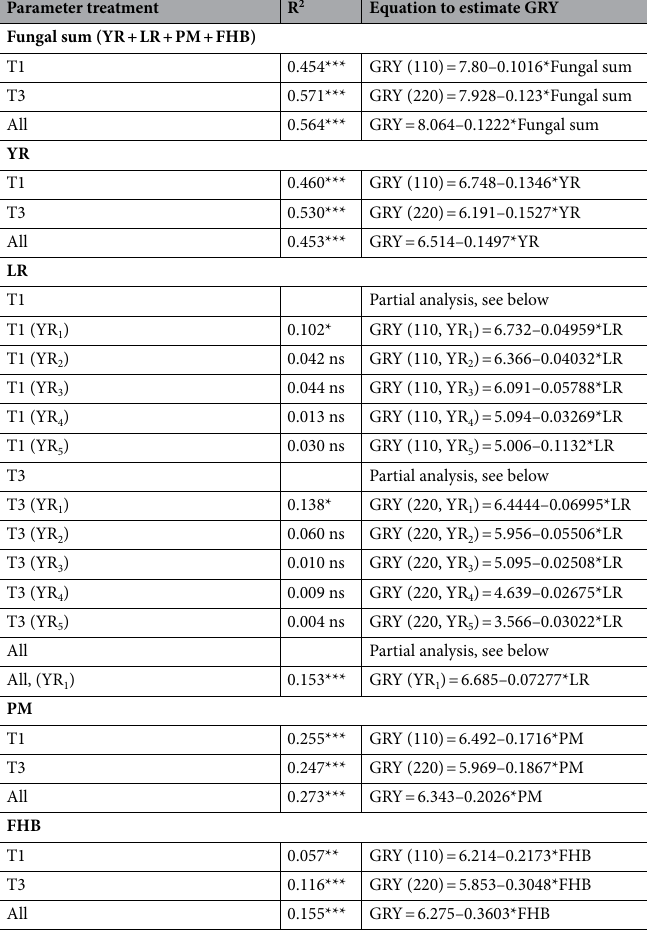
Table 4. Bivariate analysis between diseases (YR, LR including LR by YR classes, PM, FHB), and yield (GRY) based on LSmeans (observations treatment-specific, over years and repeats) assuming a linear model with variance explained (R 2 ) and significance levels of p values of each model tested, and equations of linear fit to estimate grain yield from values of each disease. T1, T3, treatment 1, treatment 3; YR, stripe rust; LR, leaf rust; YR 1 -YR 5 , quantile classes of YR infestation (YR 1 < 4.0455%, YR 2 4.0455 to 6.1509%, YR 3 6.1509 to 9.1852%, YR 4 9.1852 to 13.242%, YR 5 13.242 to 31%); PM, powdery mildew; FHB, Fusarium head blight; GRY, grain yield; Signif. p, significance level of p value: *** < 0.001, ** < 0.01, * < 0.05, ns not